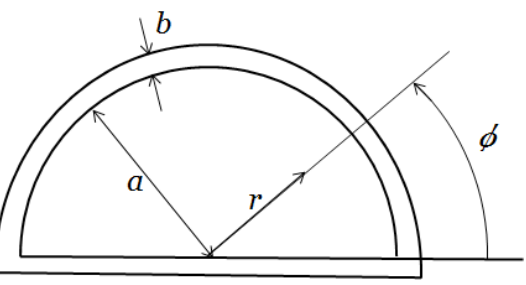
Figure 5. Cross-section drawing of the